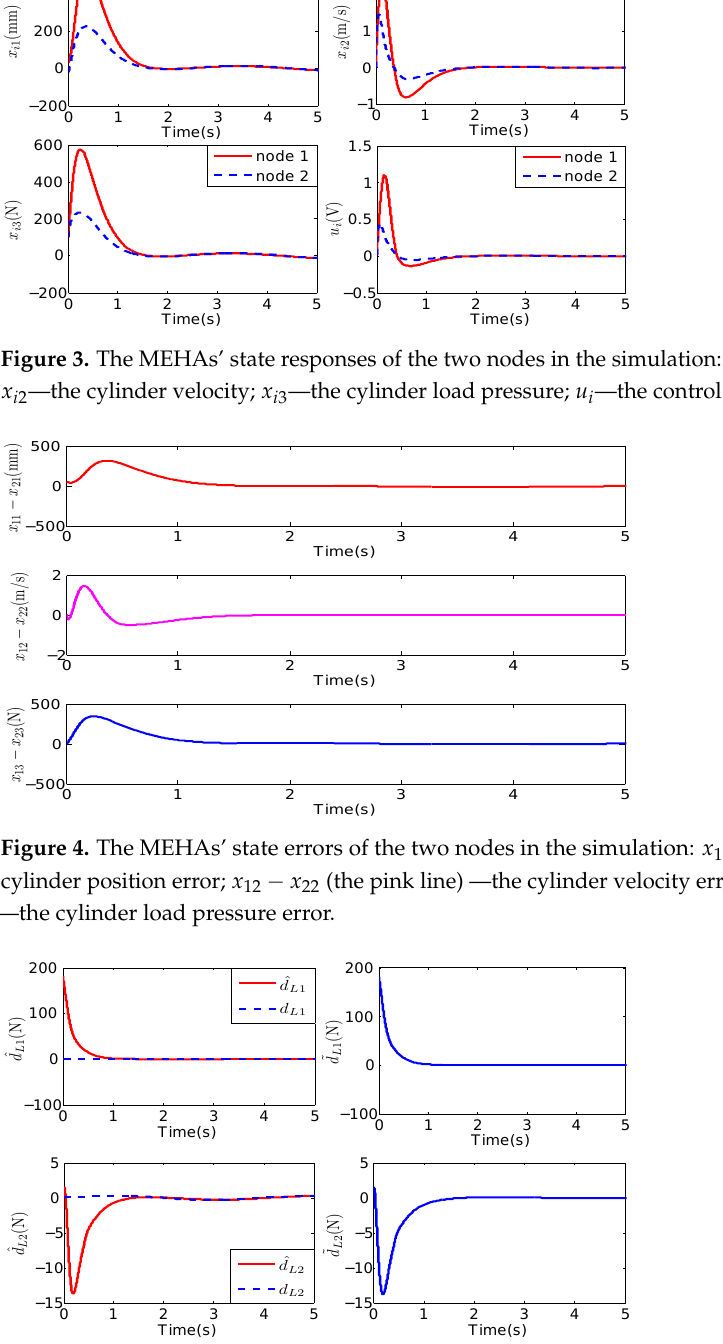
Figure 5. The disturbance observers and their corresponding errors of the two nodes in the simulation: d Li is the disturbance actual value, ˆ d Li is the disturbance observer estimation, ˜ d Li is the disturbance estimation